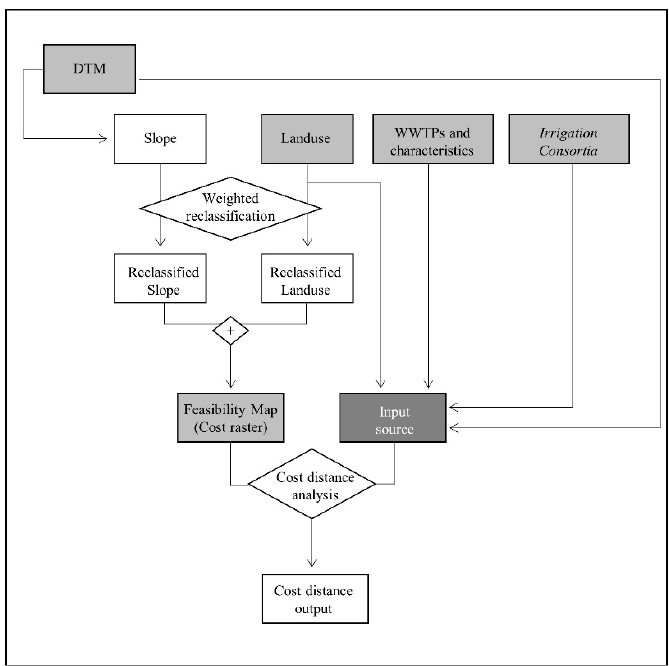
Figure 3. GIS spatial analysis and the cost-distance procedure scheme.